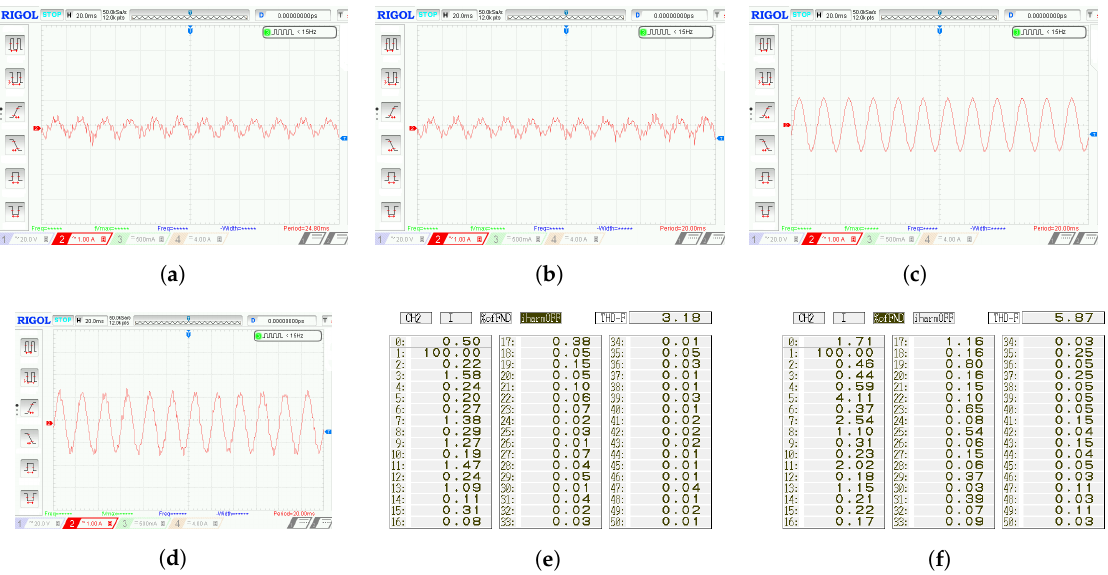
Figure 17. ( a ) The output current of APF of Scheme I; ( b ) the output current of APF of Scheme II; ( c ) the grid current waveform of Scheme I; ( d ) the grid current waveform of Scheme II; ( e ) THD for ( c ); ( f ) THD for ( d